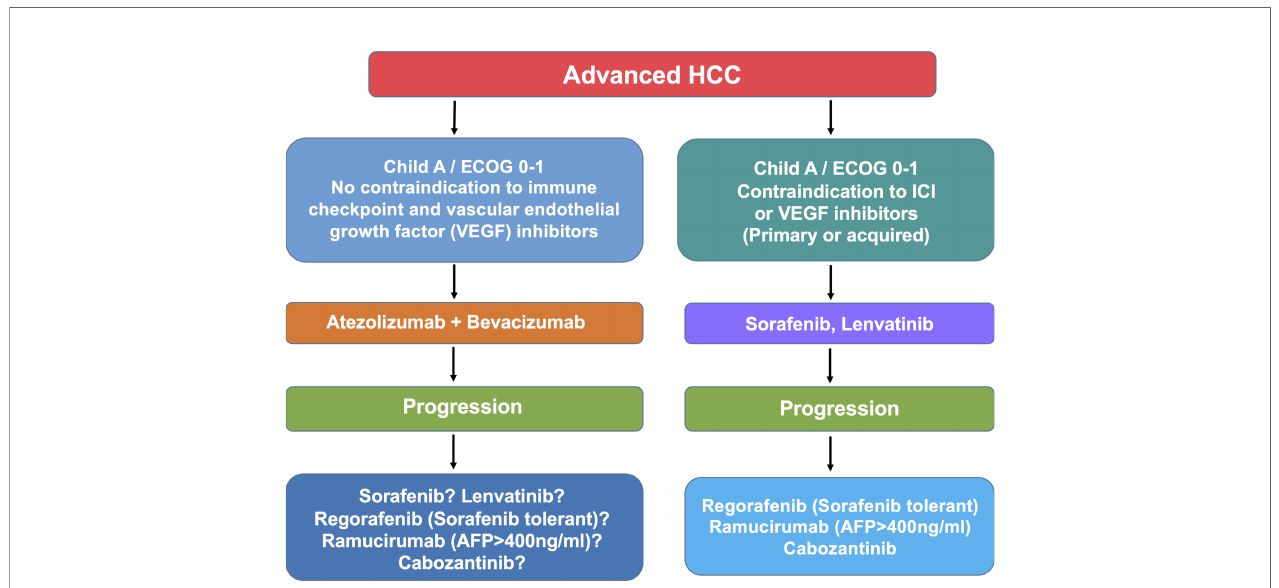
FIGURE 1 | Algorithm illustrating the current treatment options (beyond the clinical trials) for patients with advanced HCC. Note that it remains unclear whether or not patients progressing on atezolizumab and bevacizumab bene fi t from second-line drugs tested such as sorafenib, lenvatinib, ramucirumab, and cabozantinib. Therefore, patients who develop adverse effects leading to the withdrawal of atezolizumab and bevacizumab should be offered the available sequence of targeted